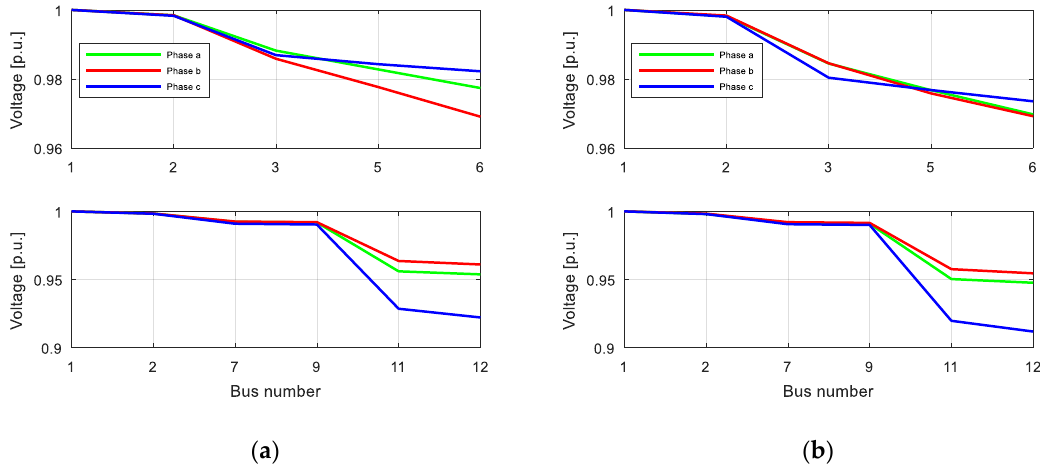
Figure 7. Scenario 0. Bus voltage profiles for branches B1 (up) and B2 (down) at the hours: ( a ) Peak-H and ( b ) Peak-L.